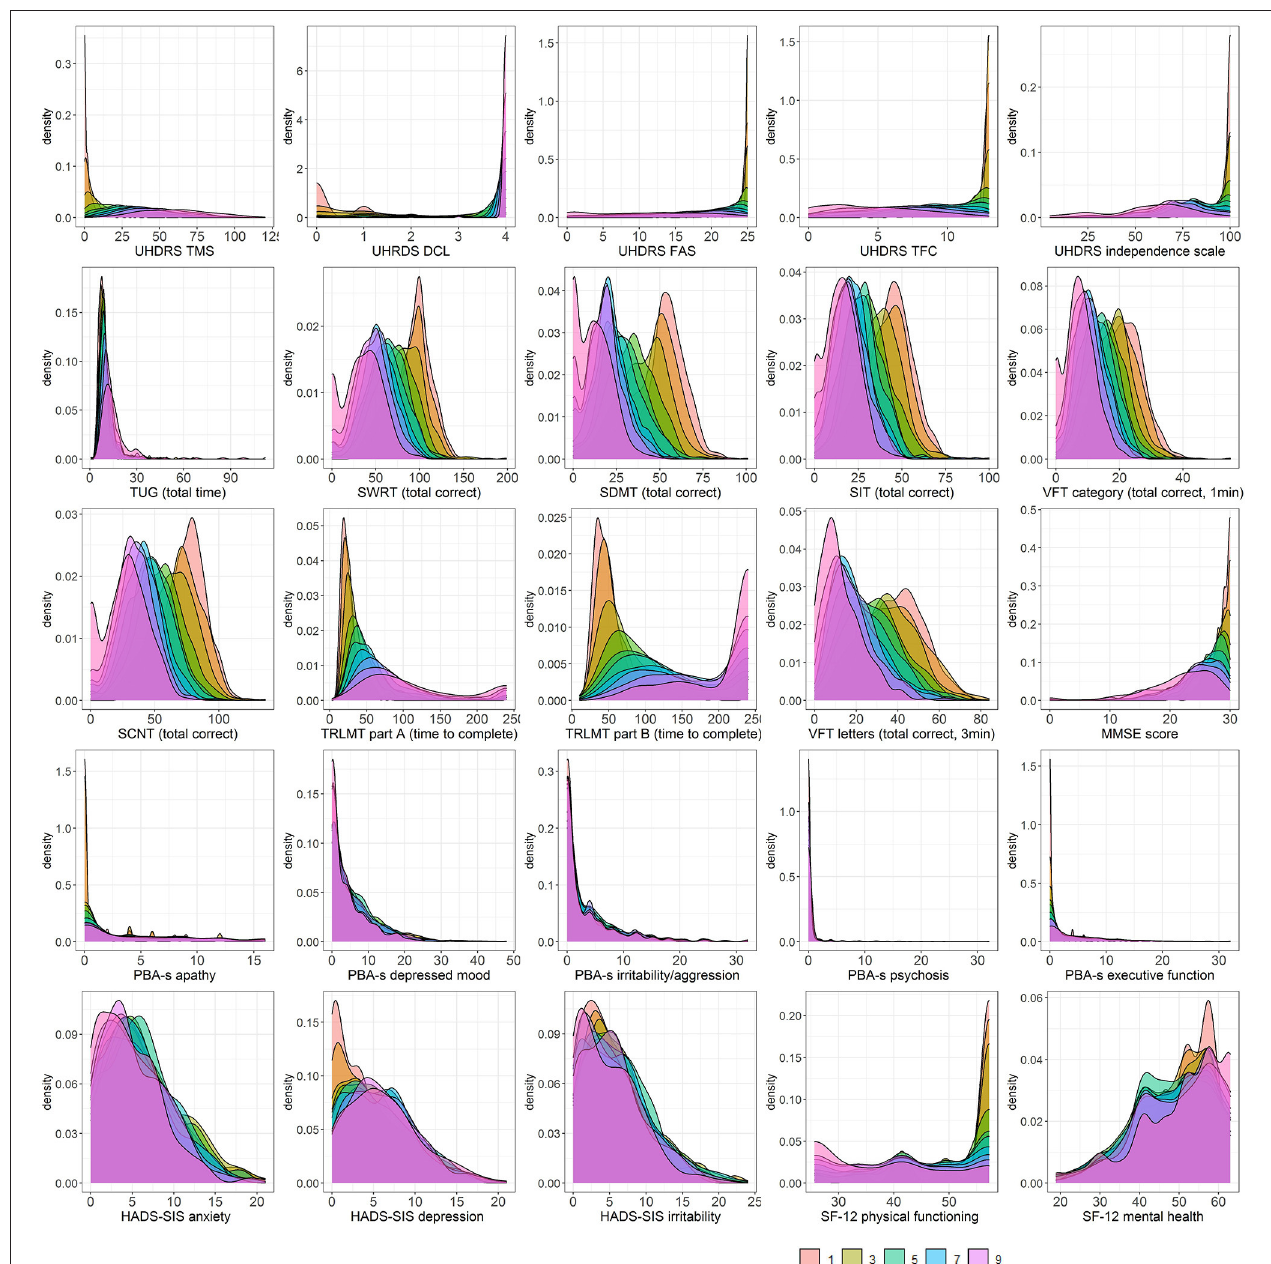
FIGURE 3 | Density plots of clinical assessment data by CAP score. Color legend for each CAP decile: